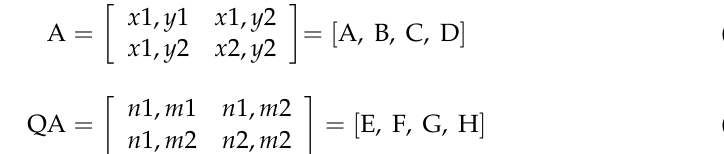
Figure 6. The reference position of the object recognized as an anchor box. Equation (6) represents the anchor box coordinates of the object, and Equation (7) represents the anchor box coordinates of the QR code. Both indicators form a rectangular shape made up of four points.